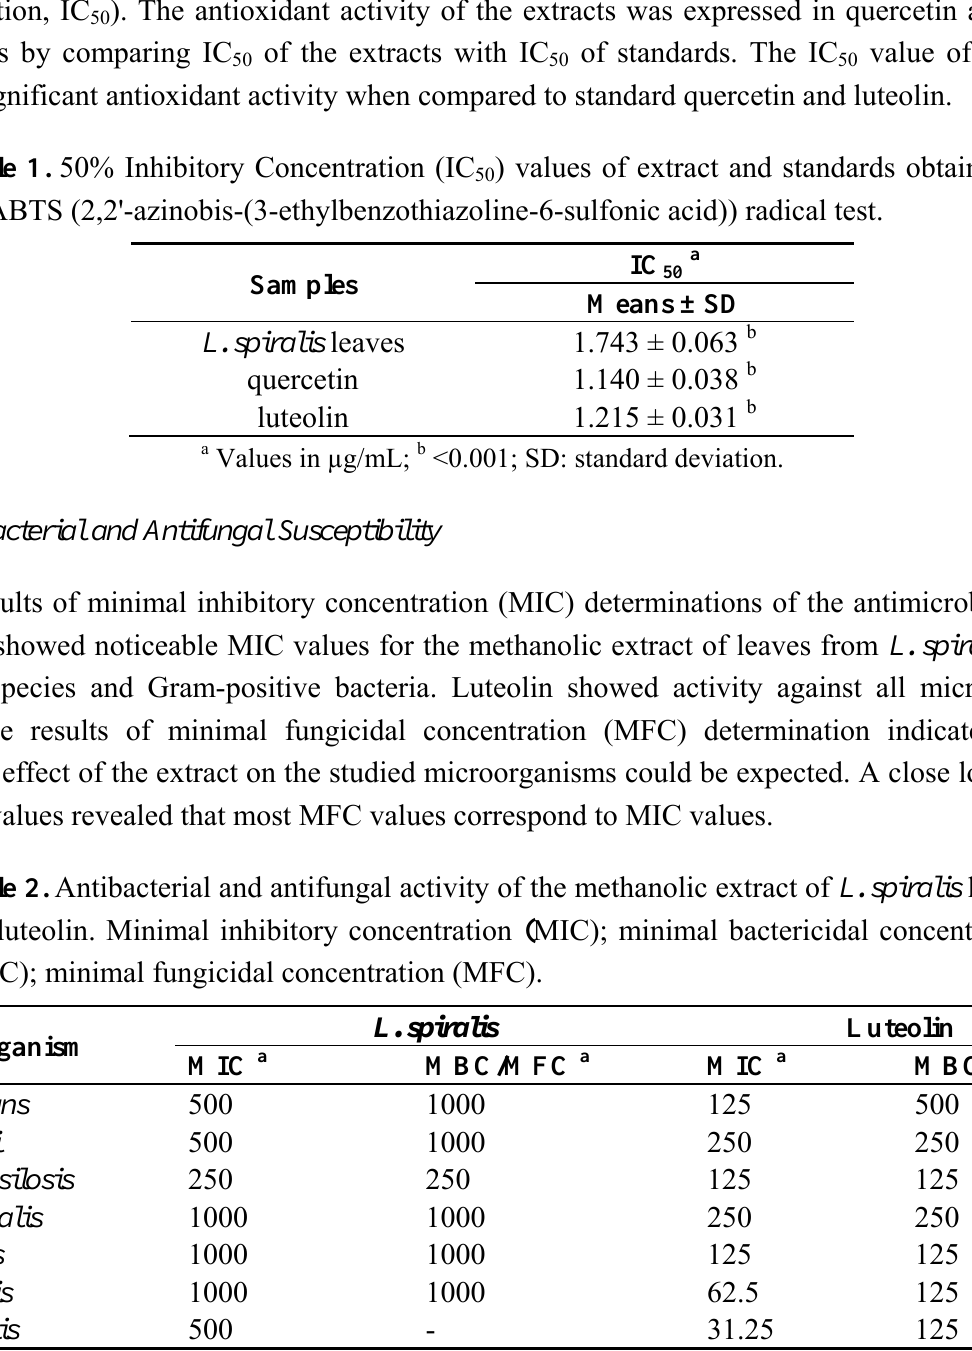
) values of extract and standards obtained in 50